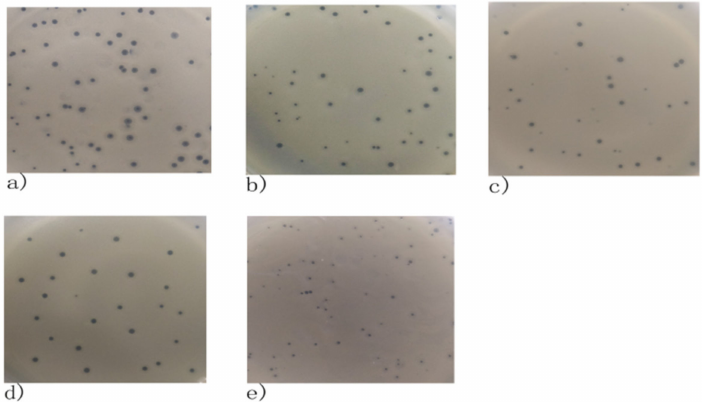
Figure 1. The plaques formed by S. aureus phages isolated from clinical mastitis. All the five phages could produce clear plaques. The plaque diameters of 4086-1, 4086-2, 4086-3, 4086-4 were about 2–3 mm, while that of 4086-6 was about 1 mm. ( a ) Phage 4086-1; ( b ) Phage 4086-2; ( c ) Phage 4086-3; ( d ) Phage 4086-4; ( e ) Phage